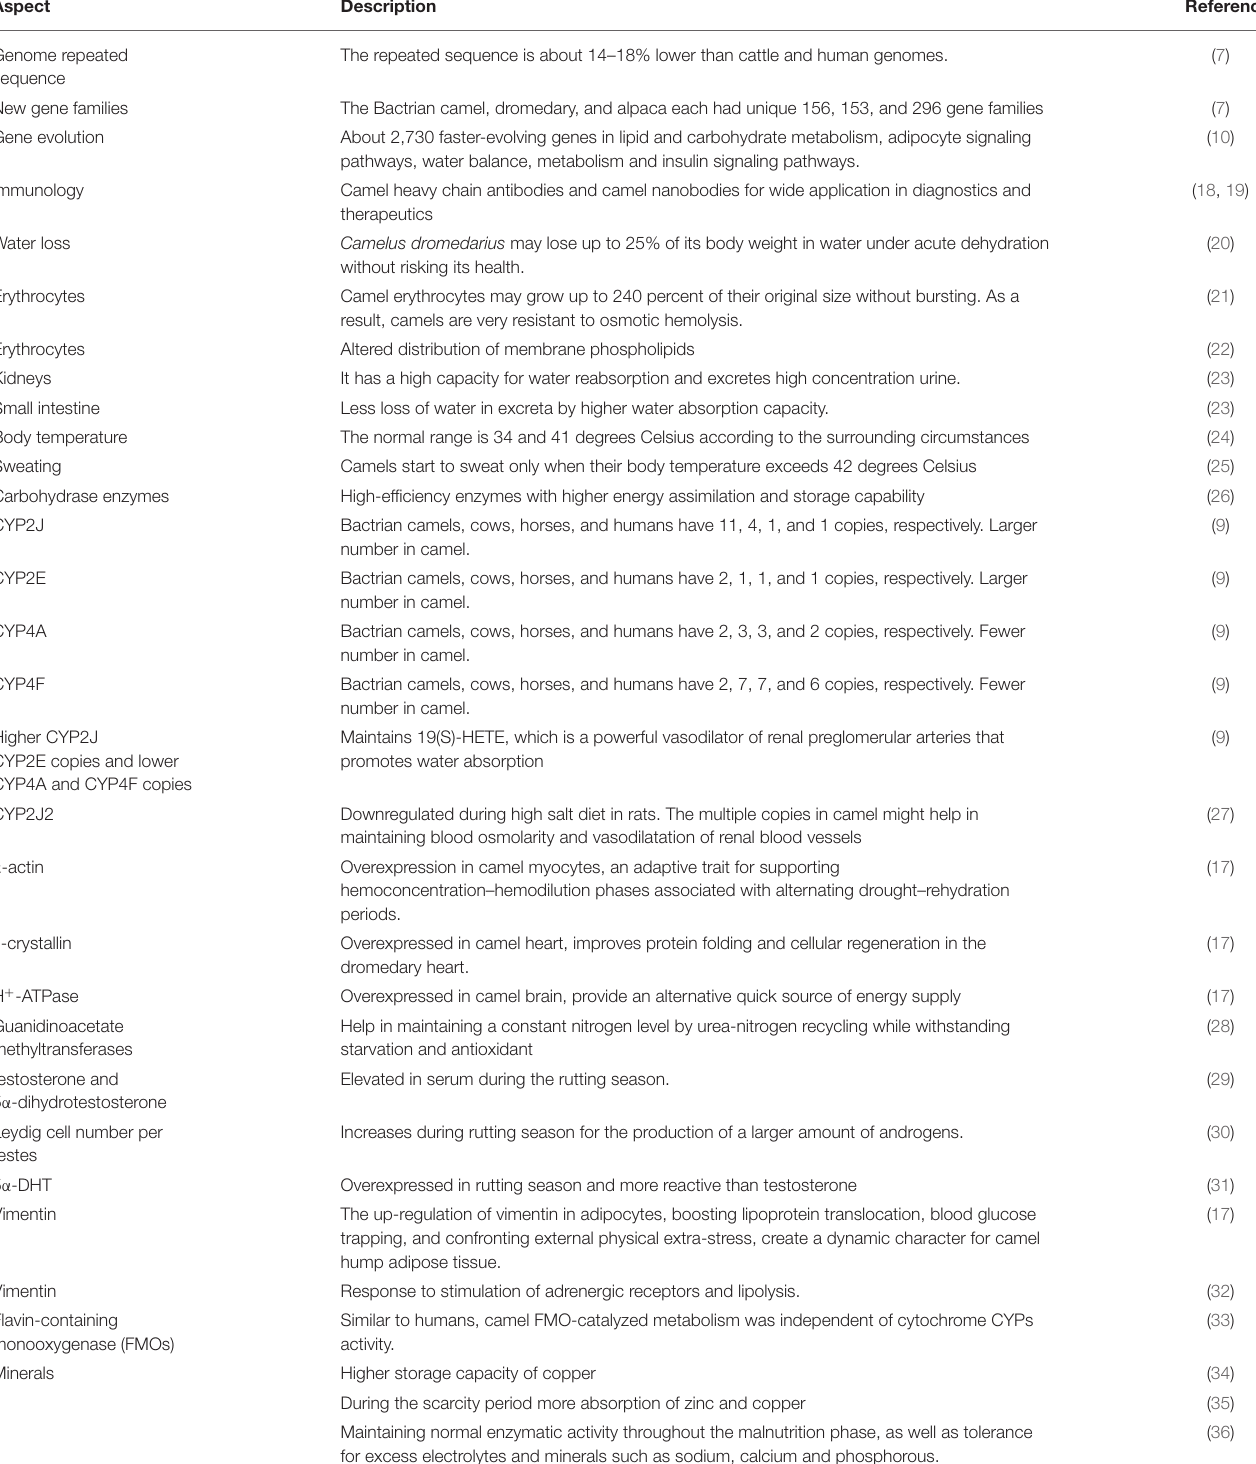
TABLE 1 | The unique aspects of camel genomics, proteomics and adaptation mechanisms. Aspect